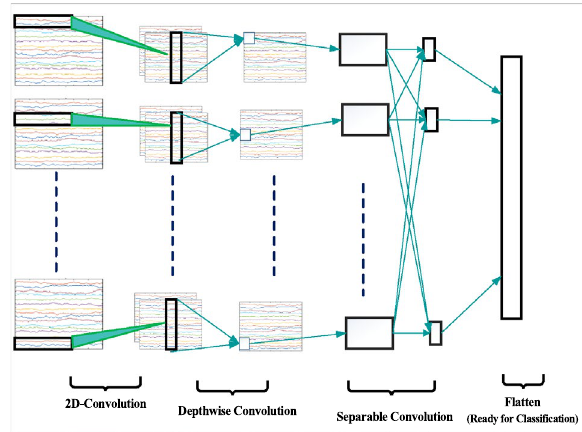
Figure 3. Overall visualization of the Compact-CNN architecture.